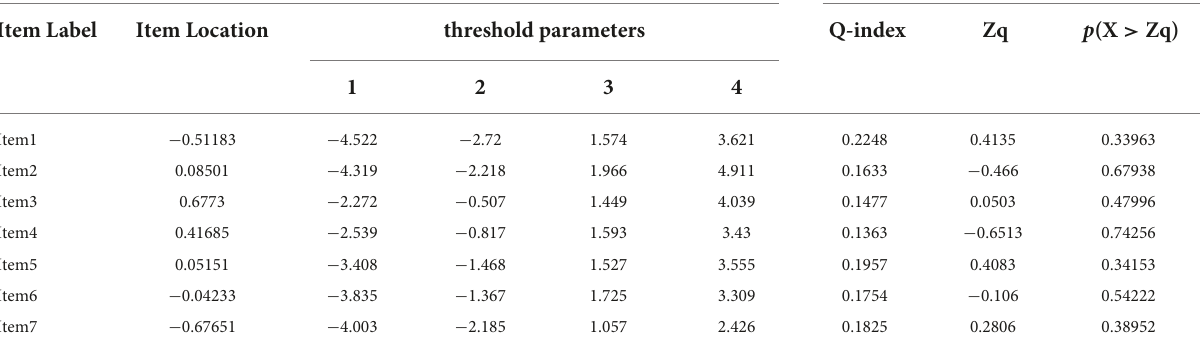
TABLE 2 Item threshold parameters and item fits assessed by the Q-index – Partial Credit